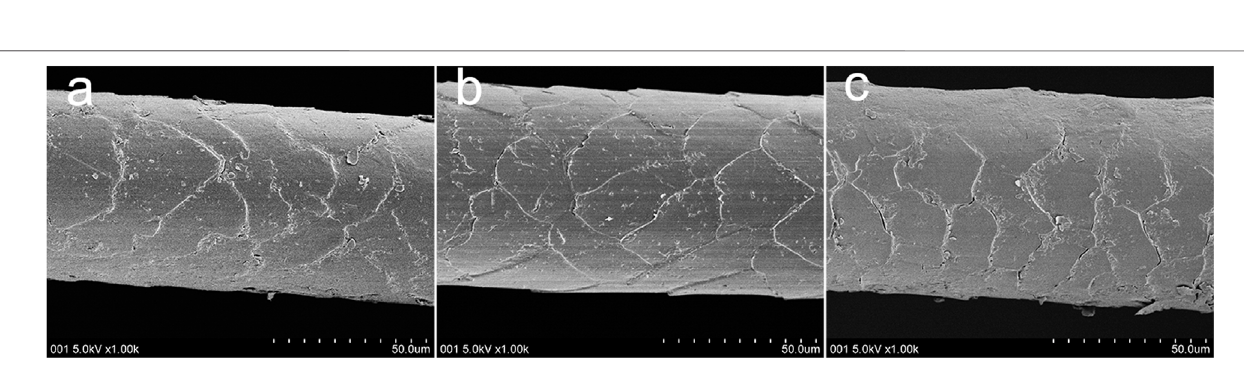
Frontiers in Bioengineering and Biotechnology |